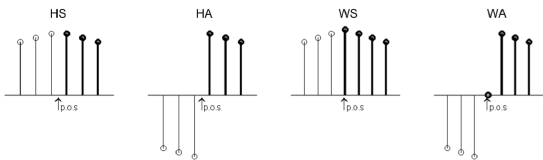
Figure 2. The four possible sequence extensions in discrete trigonometric transforms (DTTs) depending on the point of symmetry (POS) and the type. HS , HA , WS , and WA stand for half sample-symmetry, half sample anti-symmetry, whole sample-symmetry and whole sample anti-symmetry, respectively.